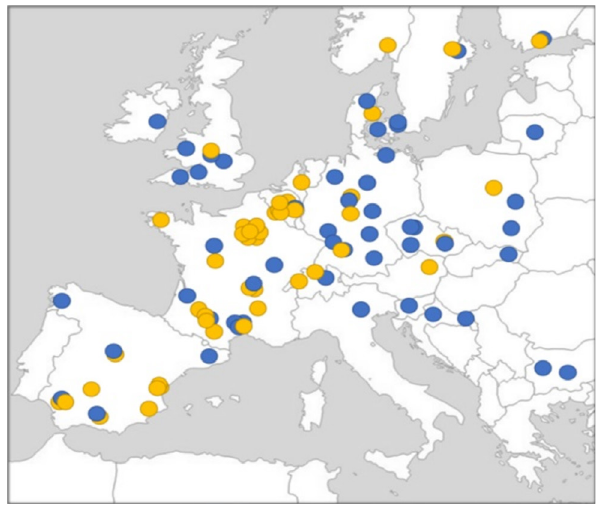
Figure 1: Mapping of stakeholders in agroecology research and trai- ning in Europe (1970-2016) (in blue: research, in yellow: